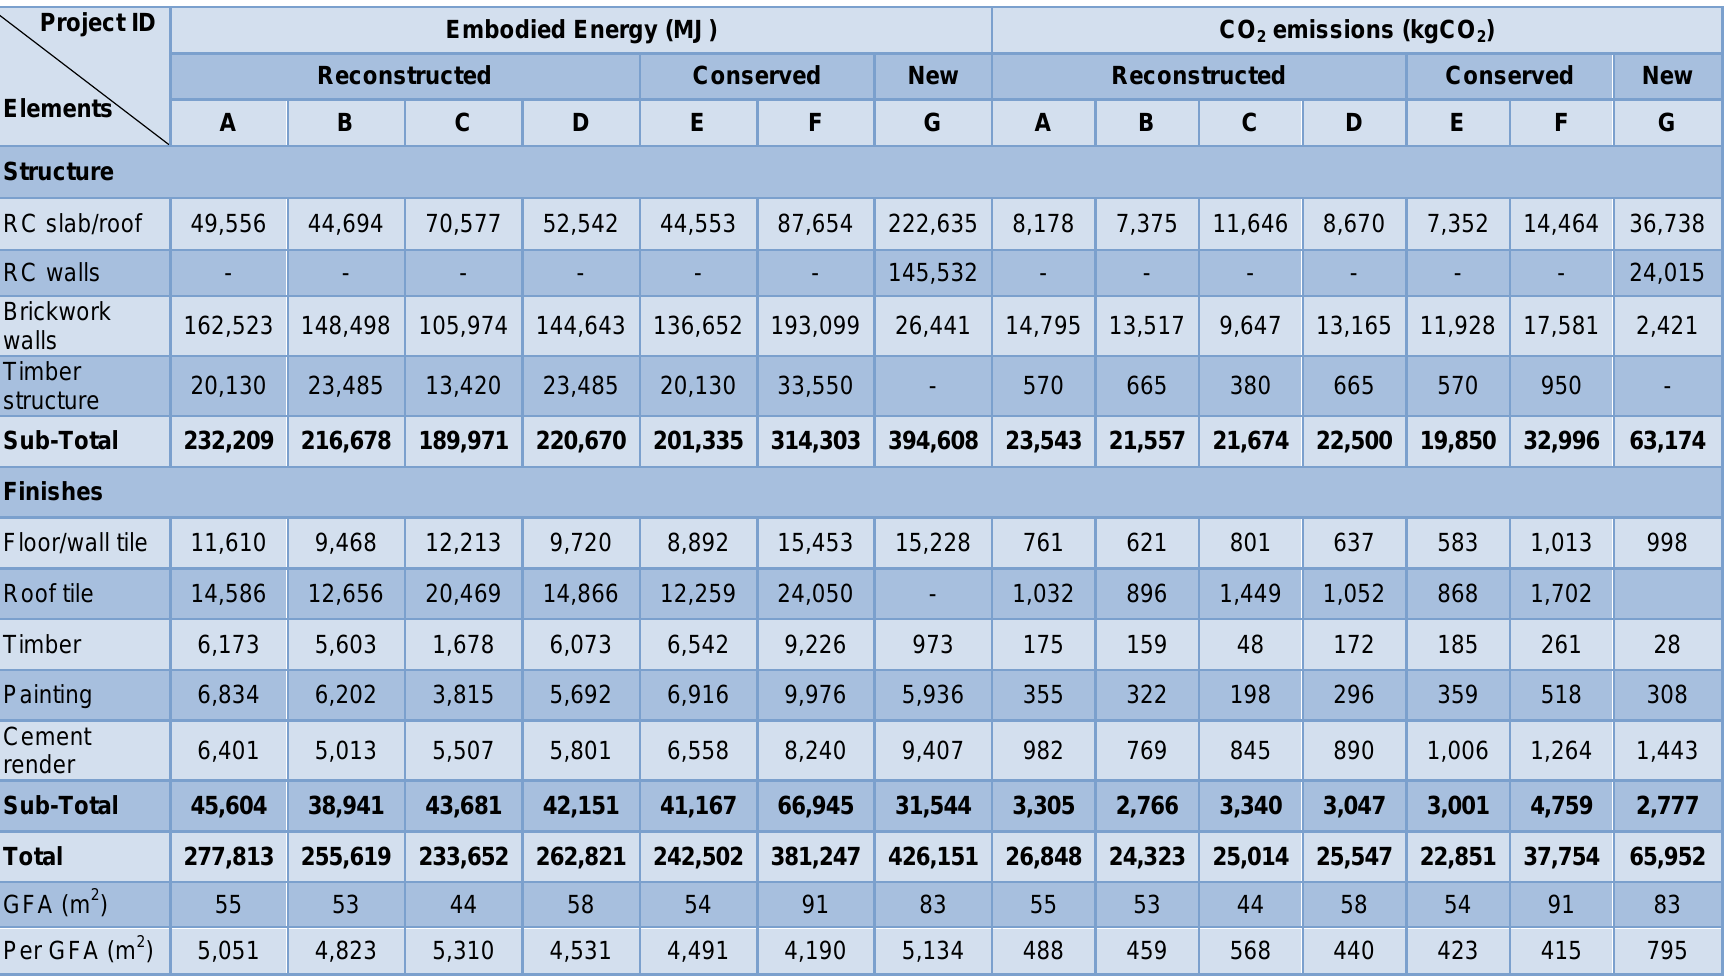
Table 2 – Summary of embodied energy and CO2